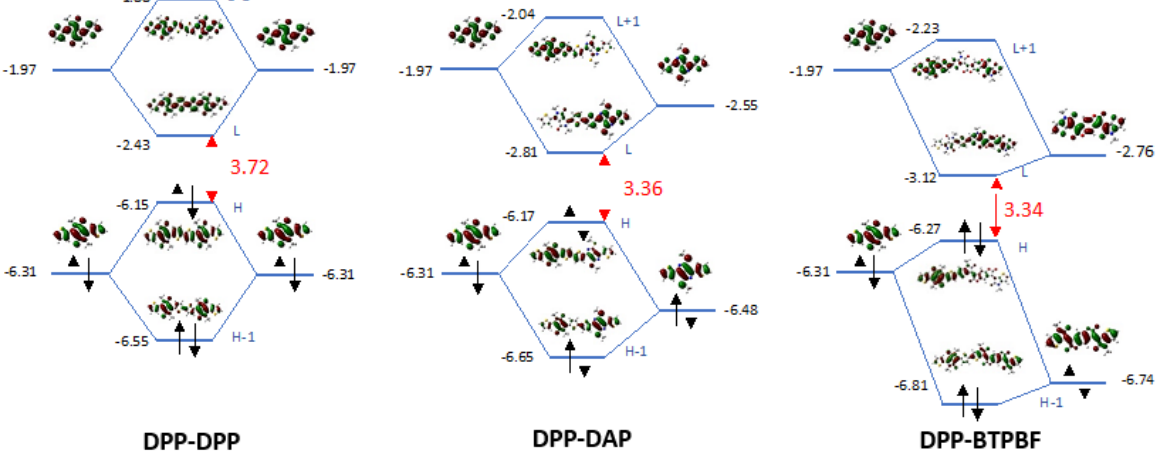
Figure 2. Energy levels (with values in eV) and shapes of frontier MOs of A-A’ dimers with A = DPP and A’ = DPP, DAP and BTPBF.